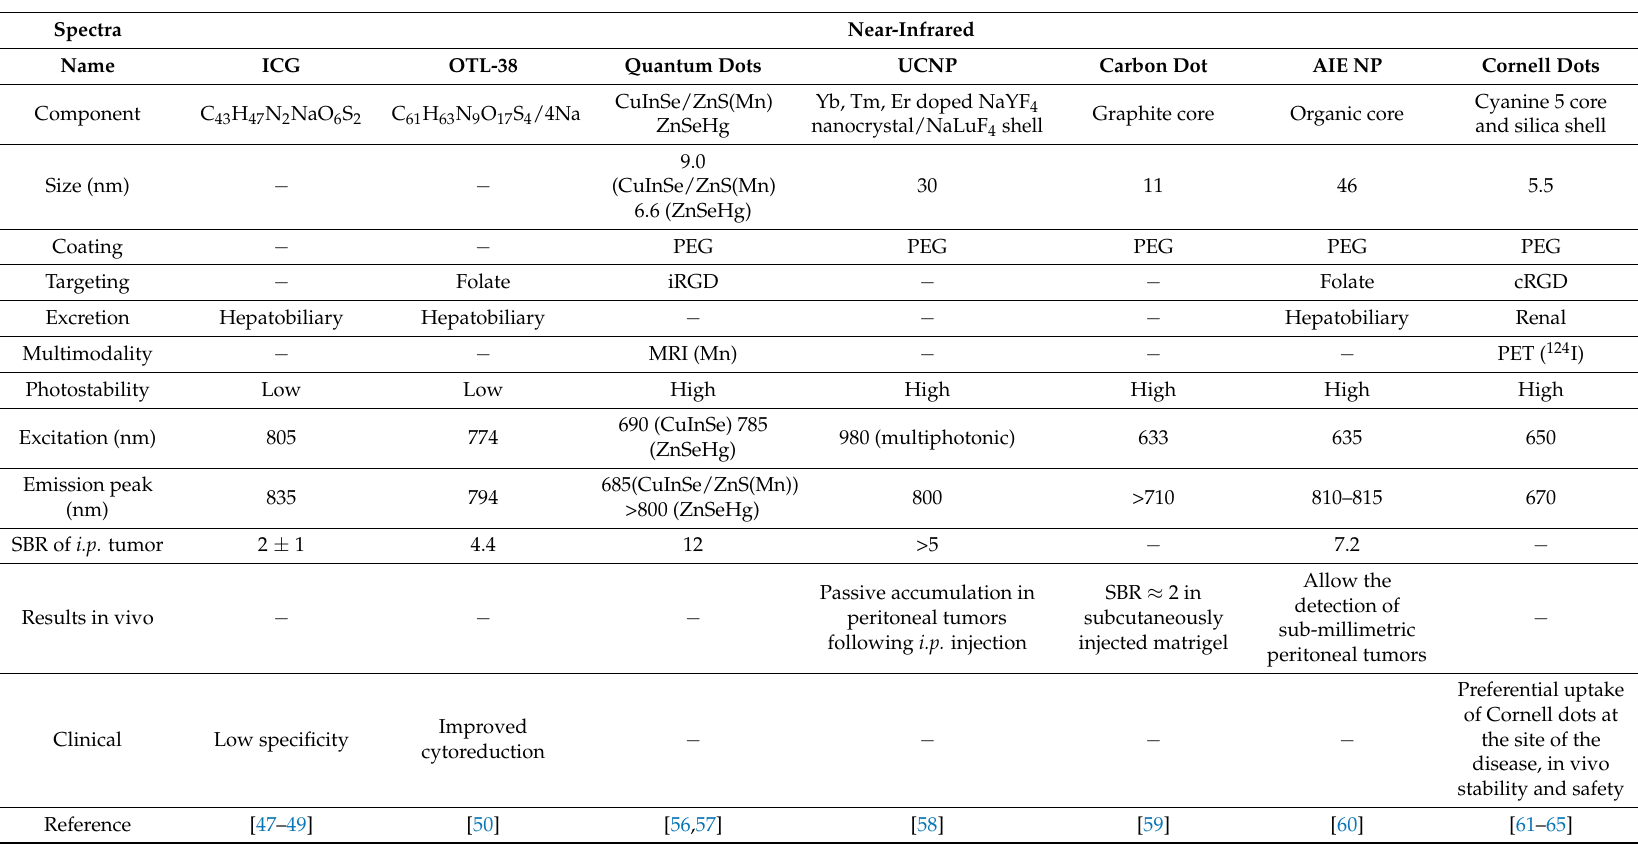
Table 1. Fluorescent near-Infrared Dye and their